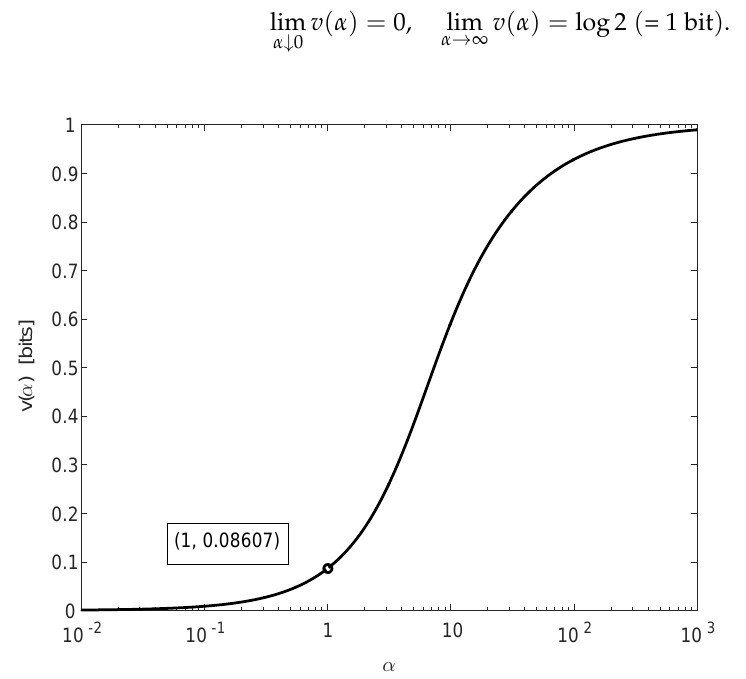
Figure 1. A plot of v : ( 0, ∞ ) → ( 0,log2 ) , which is monotonically increasing, continuous, and satisfying